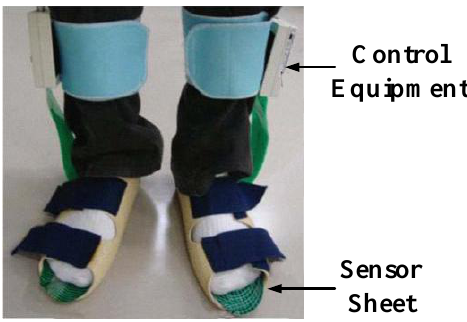
Figure 17. Biometric identification based on foot pressure pattern changes. Modified from [6].